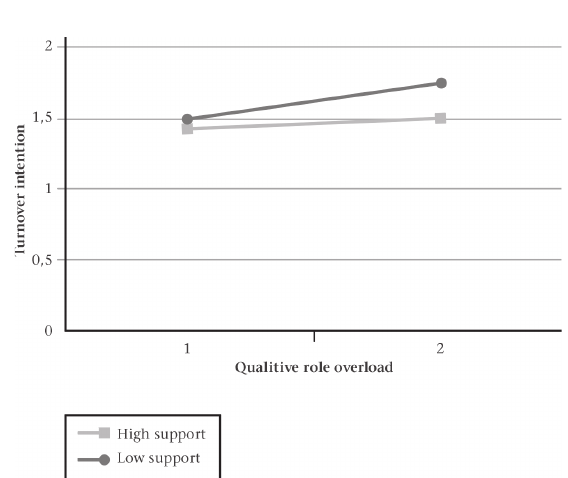
figure 2: Interaction of Colleagial Support with Qualitative Role overload in relation to Turnover